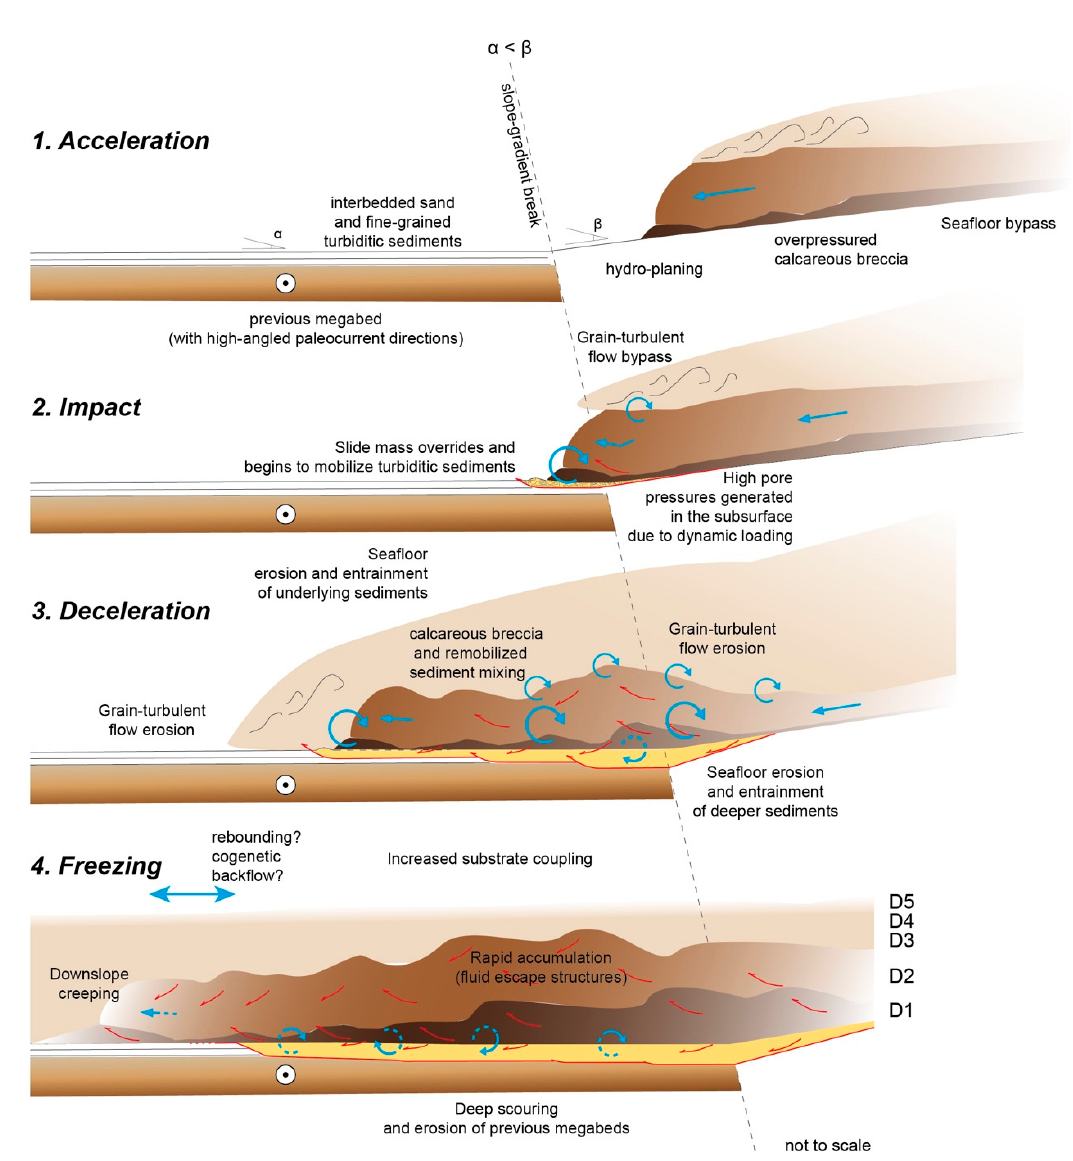
Figure 6. Cartoon showing the inferred emplacement mechanisms for the megabeds of the Anhovo section (modified and updated from [9]).